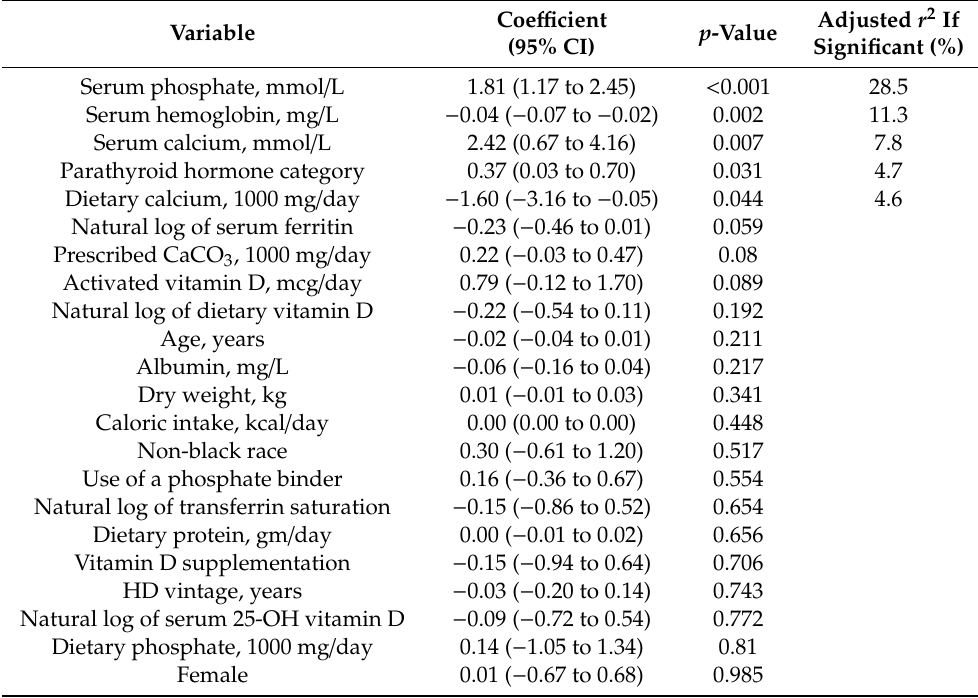
Table 3. Bivariable associations of the natural log of FGF23.